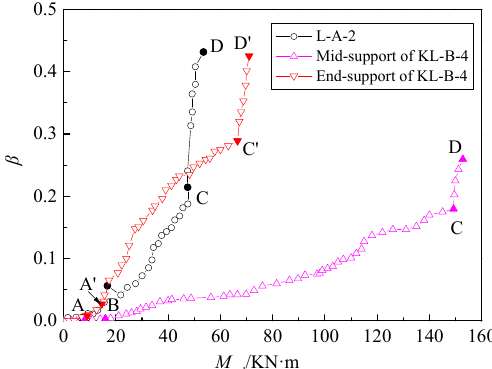
Table 4. Moment redistribution for test specimens.